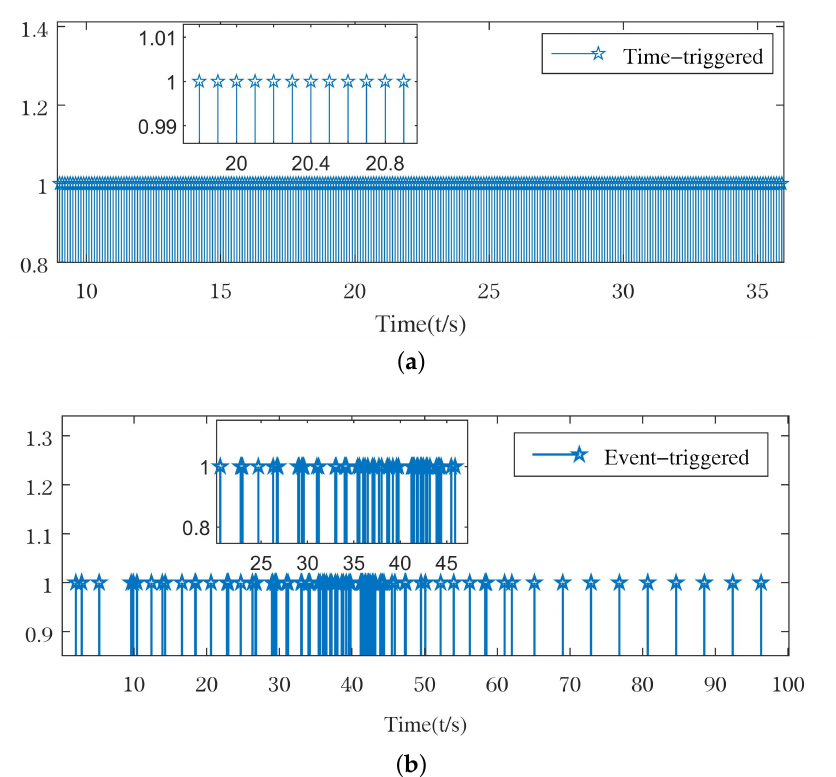
Figure 6. Sample intervals of two strategies. ( a ) The time-triggered control. ( b ) The event- triggered